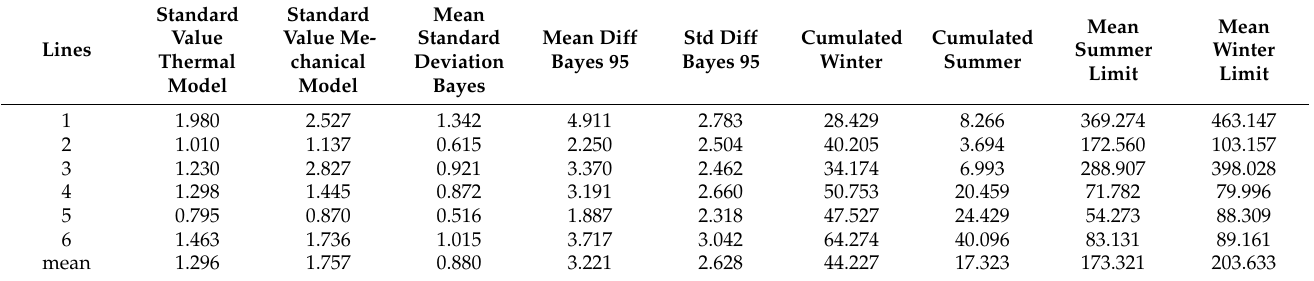
Table 1. Outputs obtained for each line analyzed and the average values obtained.